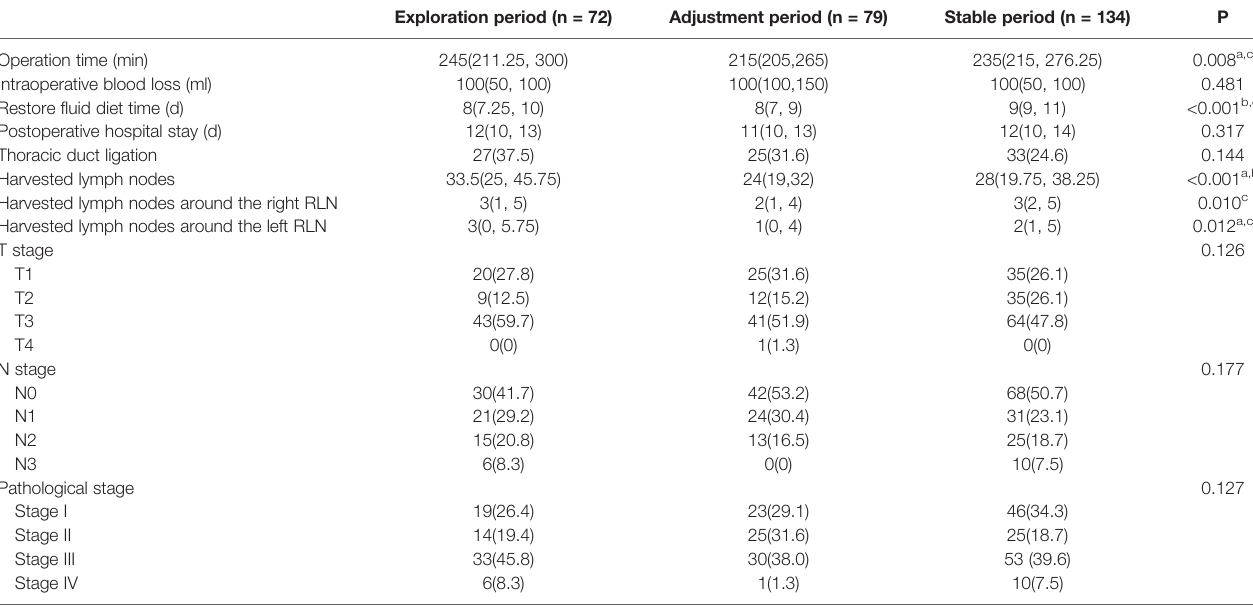
TABLE 2 | Operative and pathological outcomes of the three periods.